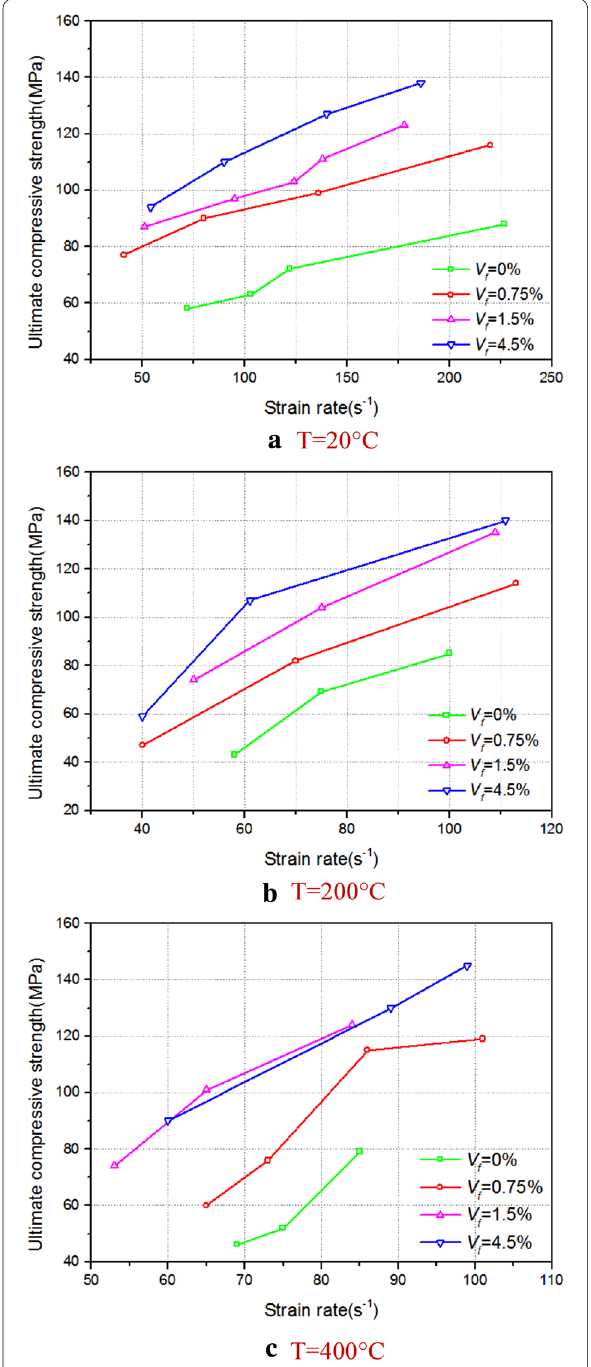
Fig. 14 Ultimate compressive strength–strain rate curves of SFRC at different temperatures.